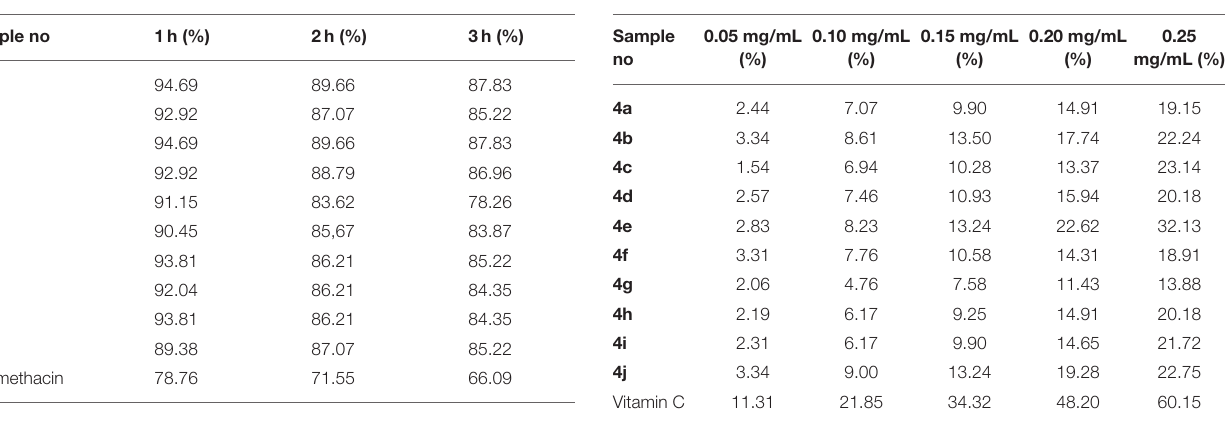
TABLE 5 | In vitro anti-oxidant (% scavenging activity).